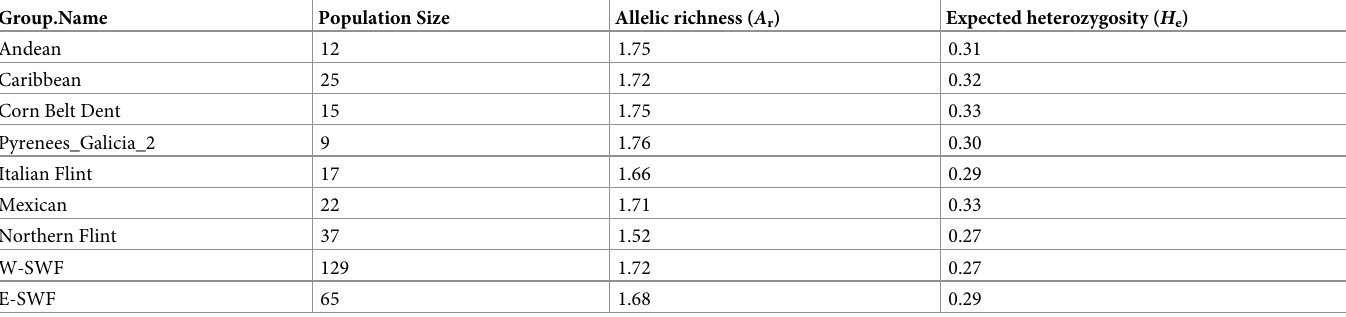
Table 1. Allelic richness ( A r ) and gene diversity (expected heterozygosity, H e ) for the two SWF groups identified with admixture at K = 2 and the 7 genetic groups previously identified in Camus-Kulandaivelu et al . [10].